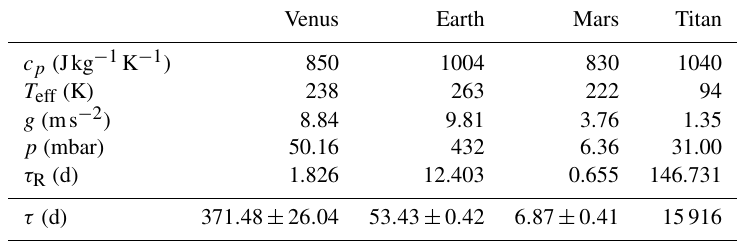
Table 5. Radiative relaxation timescale ( τ r